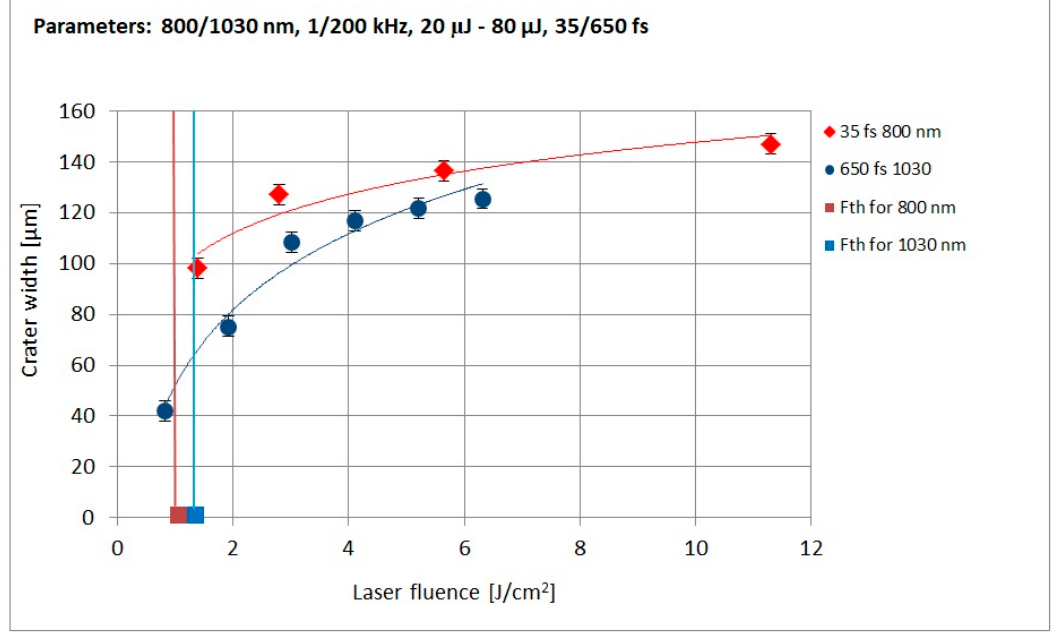
Figure 7. Ablation dependence on laser fluence for sub-picosecond and femtosecond lasers.